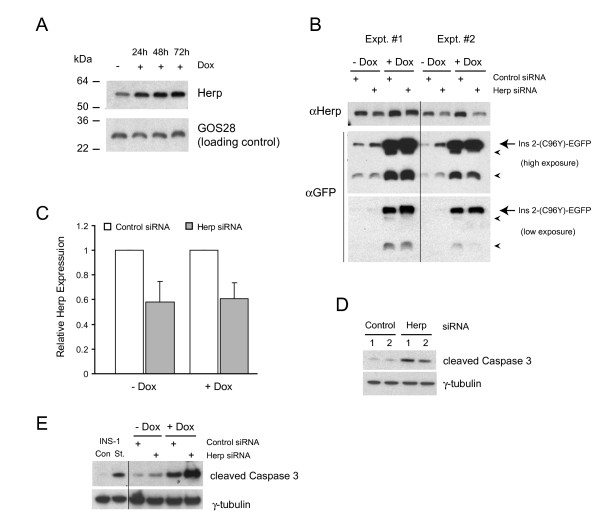
Inhibiting Herp expression increases insulin 2 (C96Y)-EGFP levels and enhances apoptosis. A. Clone #4S2 cells were untreated or treated with 2 μg/ml doxycycline for the times indicated and cell lysates were prepared and immunoblotted. B. Clone #4S2 cells were transfected with control siRNA or an siRNA directed against Herp and treated or not with doxycycline for 48 h. Cells were lysed and immunoblotted as indicated. A low and high exposure of the anti-GFP western blot is shown. Results from two of four independent experiments are shown. C. Immunoblots were quantified and the mean relative expression of Herp from 4 independent experiments is presented. D. Clone #4S2 cells were transfected with control or Herp siRNA and 48 h later apoptosis was measured by immunobloting for cleaved caspase 3. Results from two experiments are shown. E. Clone #4S2 cells were transfected as in (D) and 24 h later doxycycline was added or not for 48 h and apoptosis was measured by immunobloting for cleaved caspase 3. INS-1 cells treated or not with 0.3 mM straurosporine (St.) was included as a positive control for cleaved caspase 3.